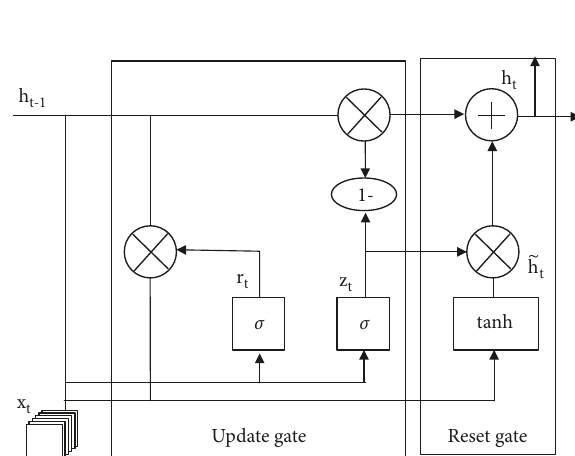
Figure 13: Bi-LSTM cell structure.